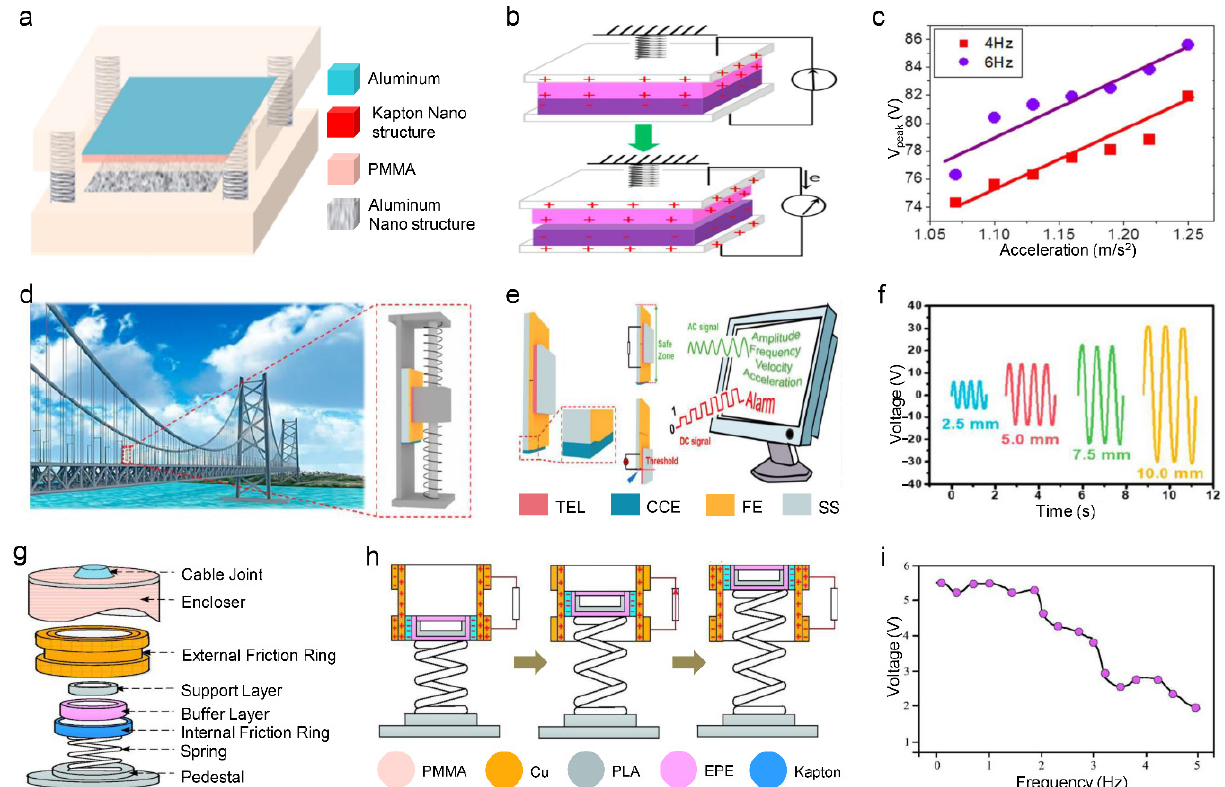
Figure 2. A spring-based vibration sensor: Part One. ( a ) Schematic illustration of the self-powered TEVA. ( b ) Working principle of the TEVA. ( c ) Relationship between peak voltage and acceleration when frequencies are 4 Hz and 6 Hz respectively. Reproduced with permission [102]. Copyright